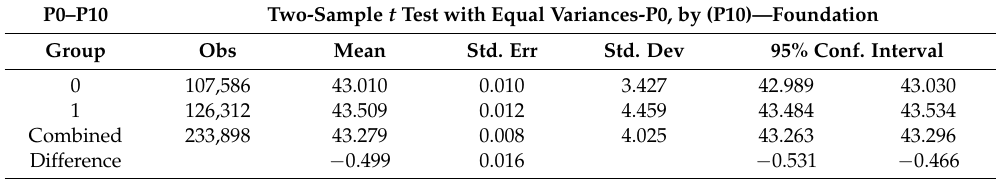
Table 7. Results: P0 by P10: Variability 499 nT between 0 and 1 with p -value: